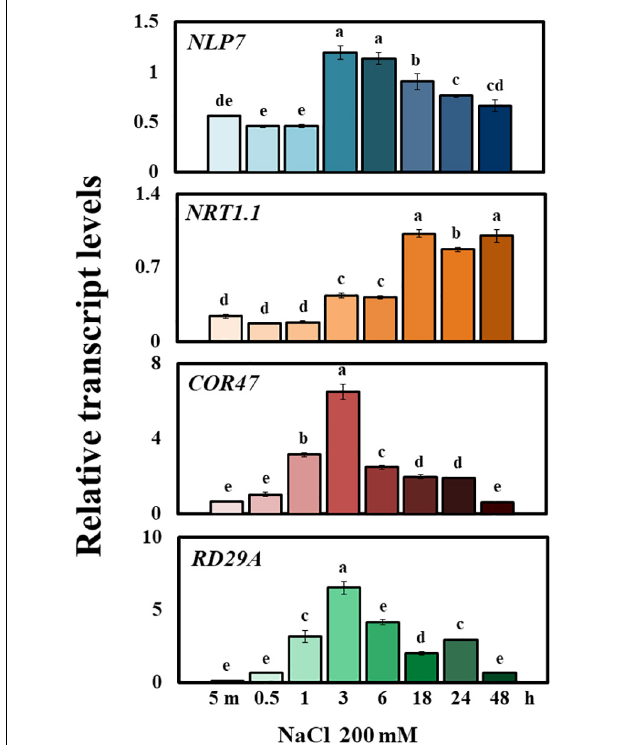
FIGURE 2 | NLP7 transcript levels were elevated in response to external salt treatment. Relative transcript levels of NLP7 , NRT1.1 , COR47 , and RD29A in Col-0 and nlp7 plants, as determined using qPCR. The seeds were germinated and grown on a nitrogen-free half-strength MS medium containing 5 mM KNO 3 for 9 days and then treated with 200 mM NaCl for 5 min to 48 h. AtActin2 was used as the internal control. Error bars represent the standard deviation of three independent replicates. Different letters (a, b, c, d, or e) within a treatment group indicate significant differences in the two-way ANOVA ( P ≤ 0.05, Tukey’s test).